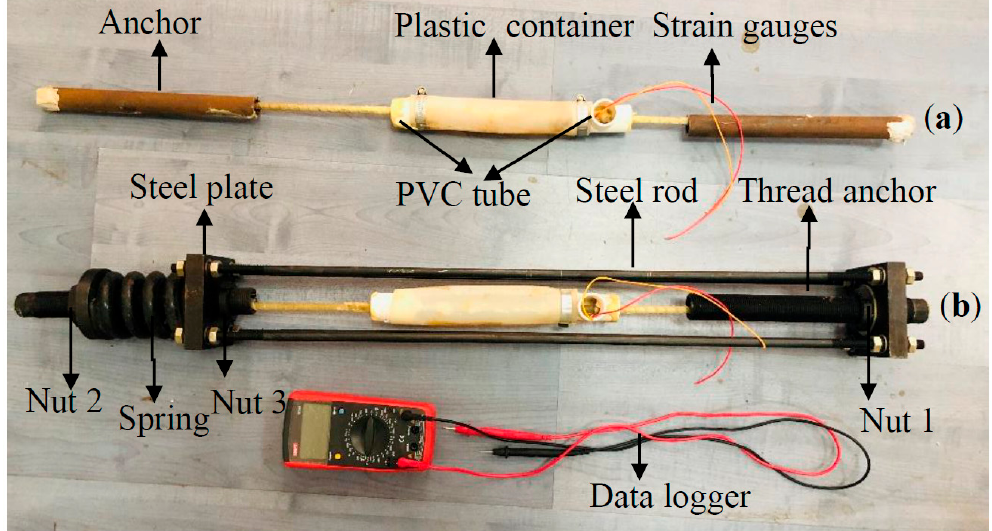
Figure 2. Test specimens: ( a ) Unstressed specimens and ( b ) stressed specimens.